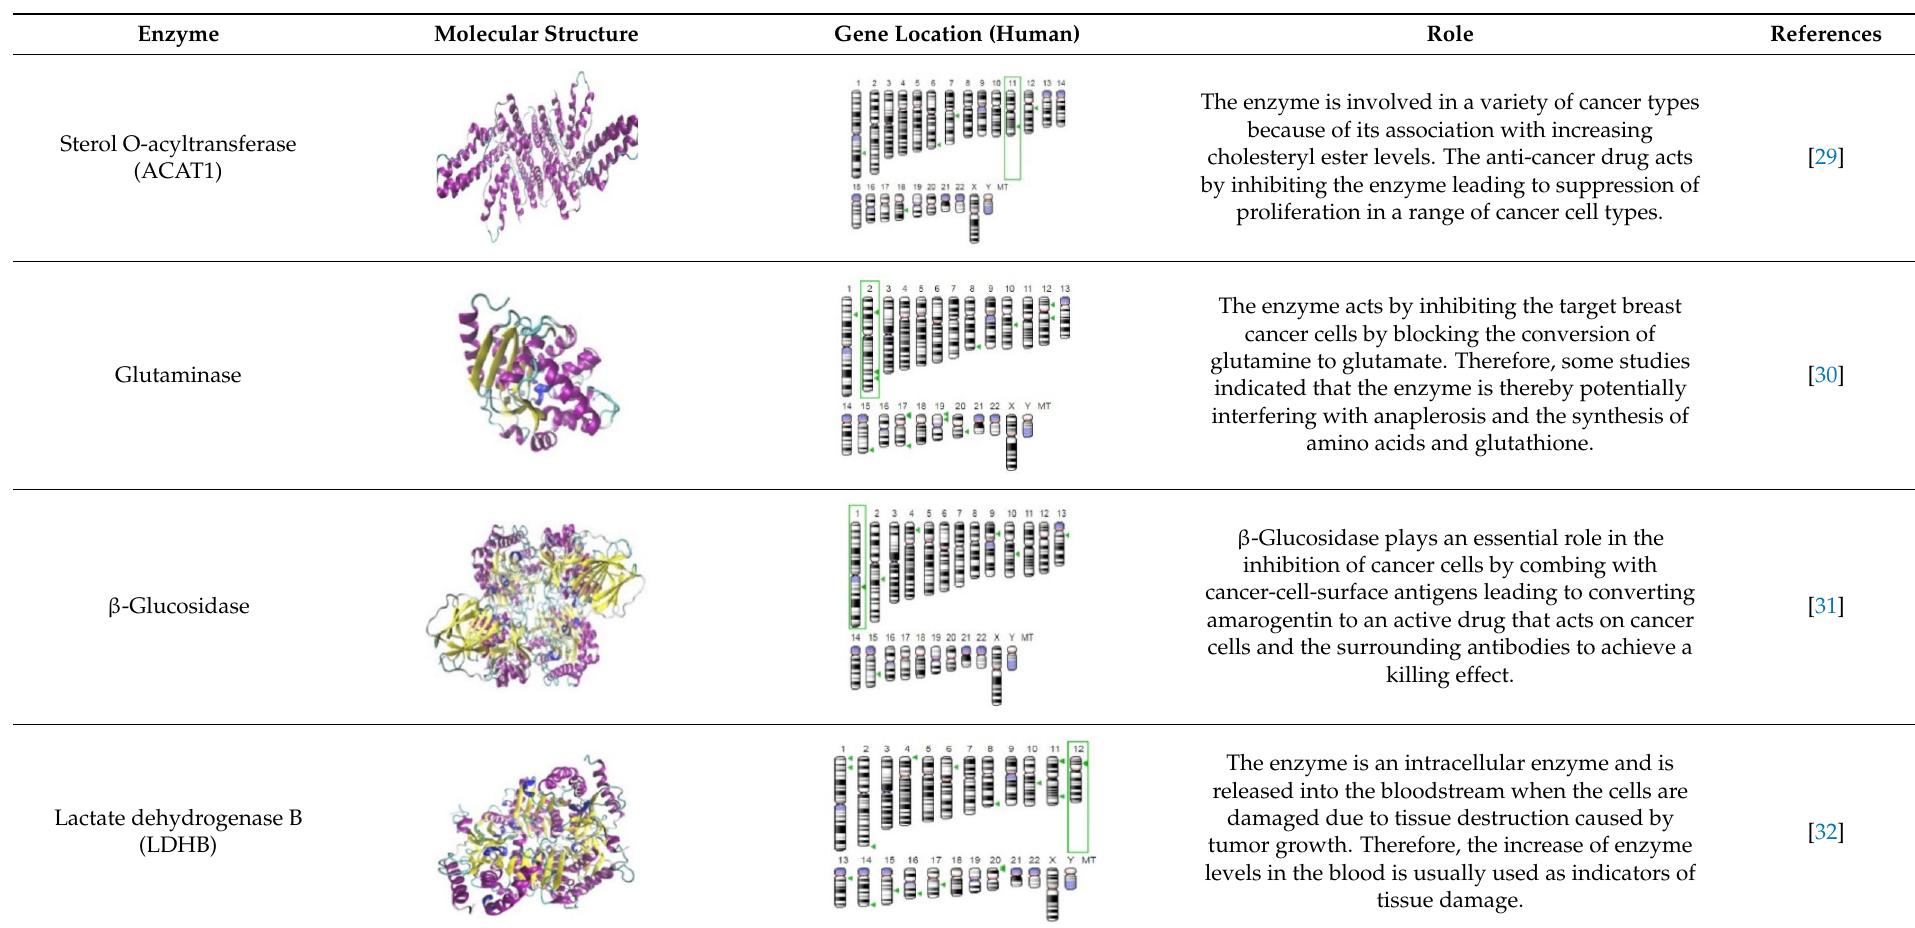
Table 3. Most common enzymes associated with cancer in